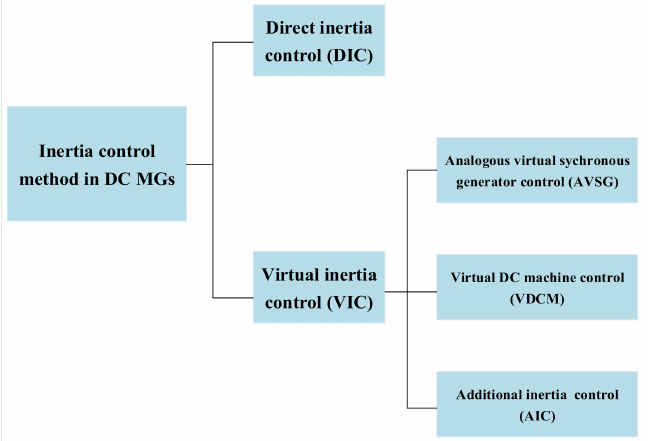
Figure 8. Classification of inertia control